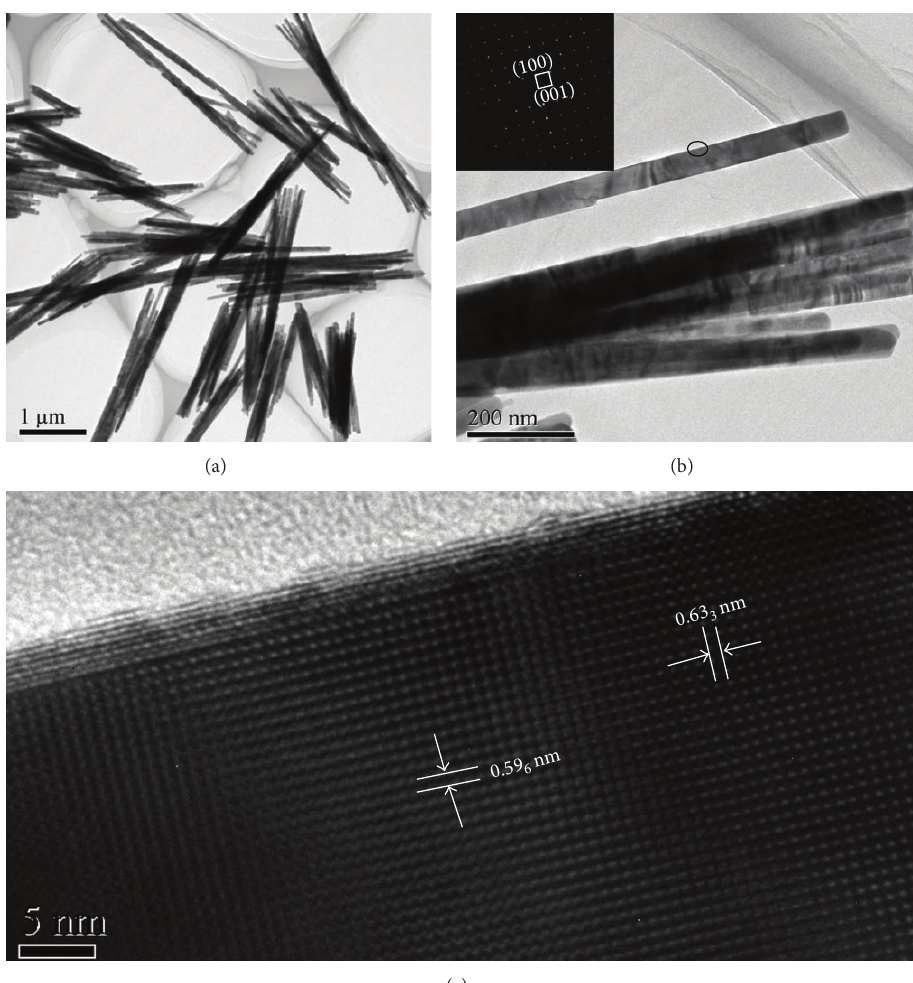
Figure 3: TEM images of bundle-shaped TbPO 4 ⋅ H 2 O nanorods (a) and (b), SAED pattern (inset in (b)), and HRTEM image (c) of the single